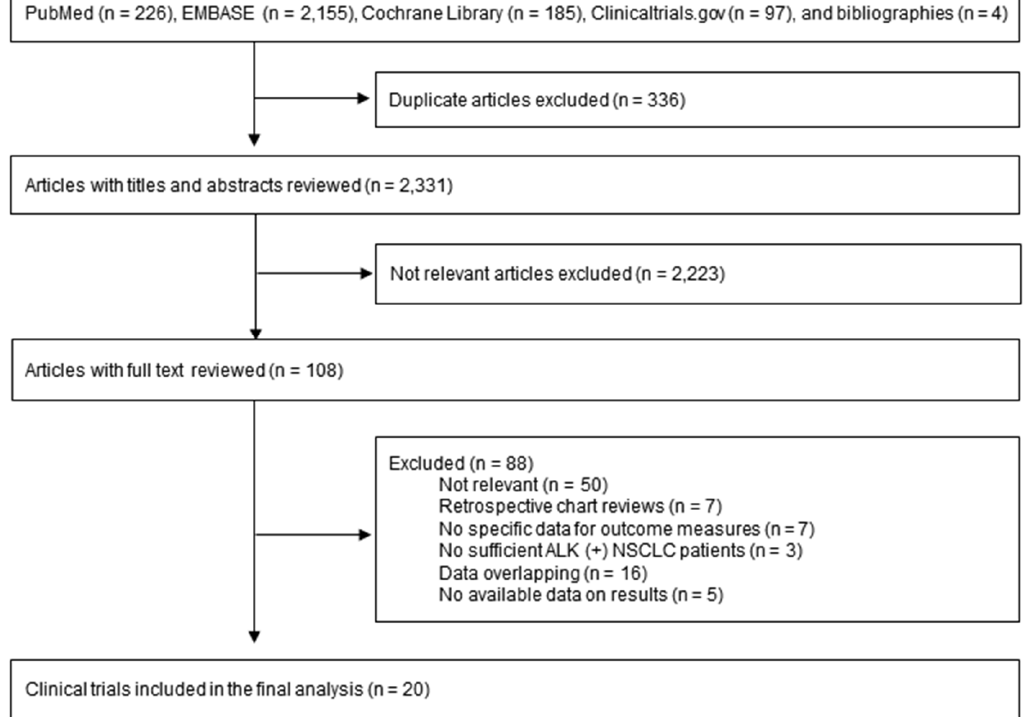
Figure 1. Flow diagram for selection of relevant clinical trials .